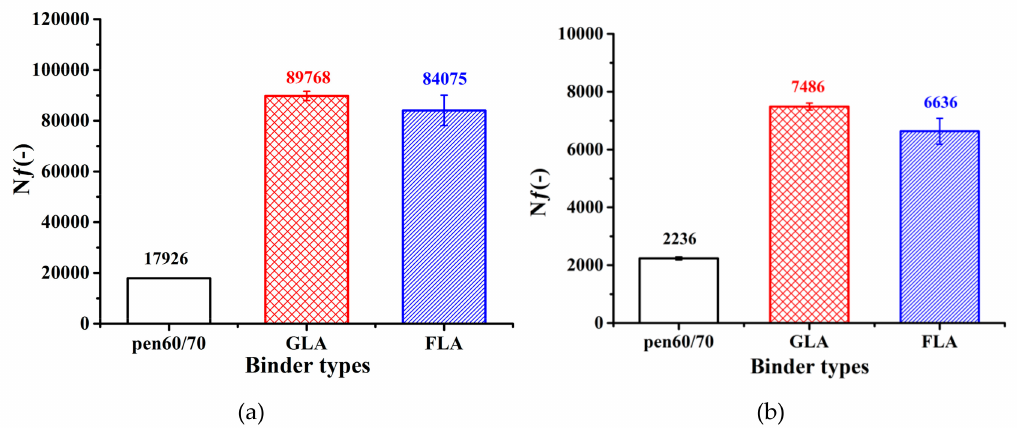
Figure 6. Liner amplitude sweep (LAS) test results: ( a ) applied strain of 2.5% and ( b ) applied strain of 5.0%.